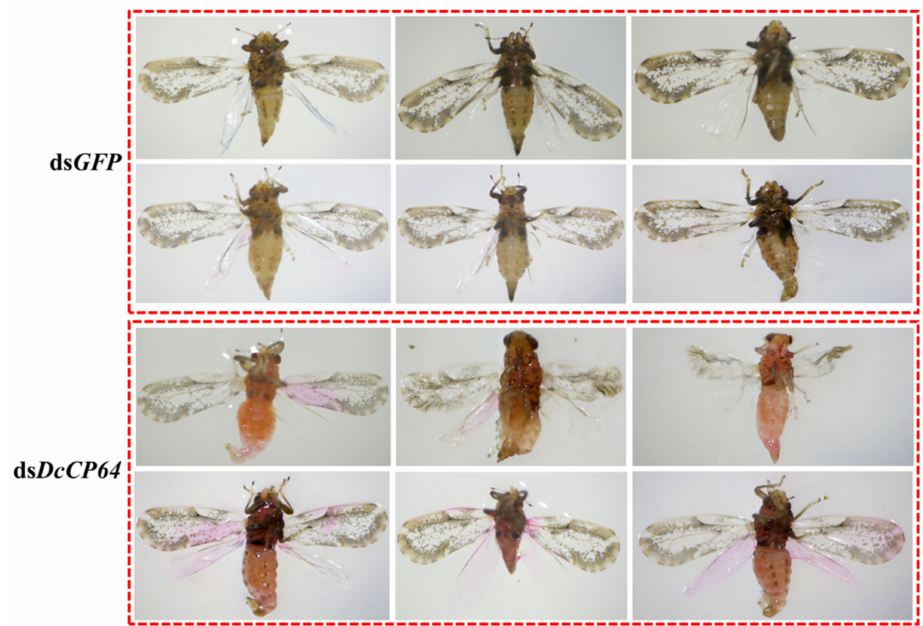
Figure 6. Effects of silencing of DcCP64 on wing and cuticle permeability. Silencing of DcCP64 caused excessive Eosin Y penetration in the forewing and entire cuticle.